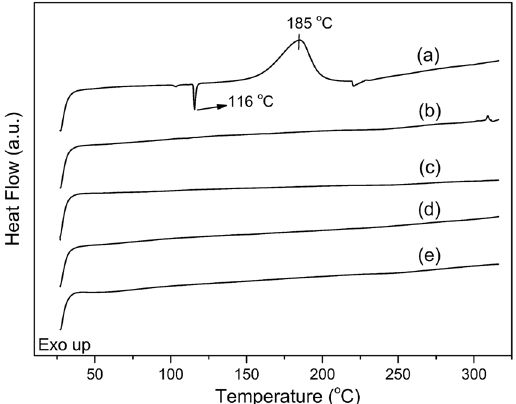
Figure 6. DSC thermographs of B-al, PPOB, S 8 mixture ( a ), PPOB 40 -B-al 40 -S 20 ( b ), 1 st ( c ), 3 rd (d), 5 th ( e ) healings.